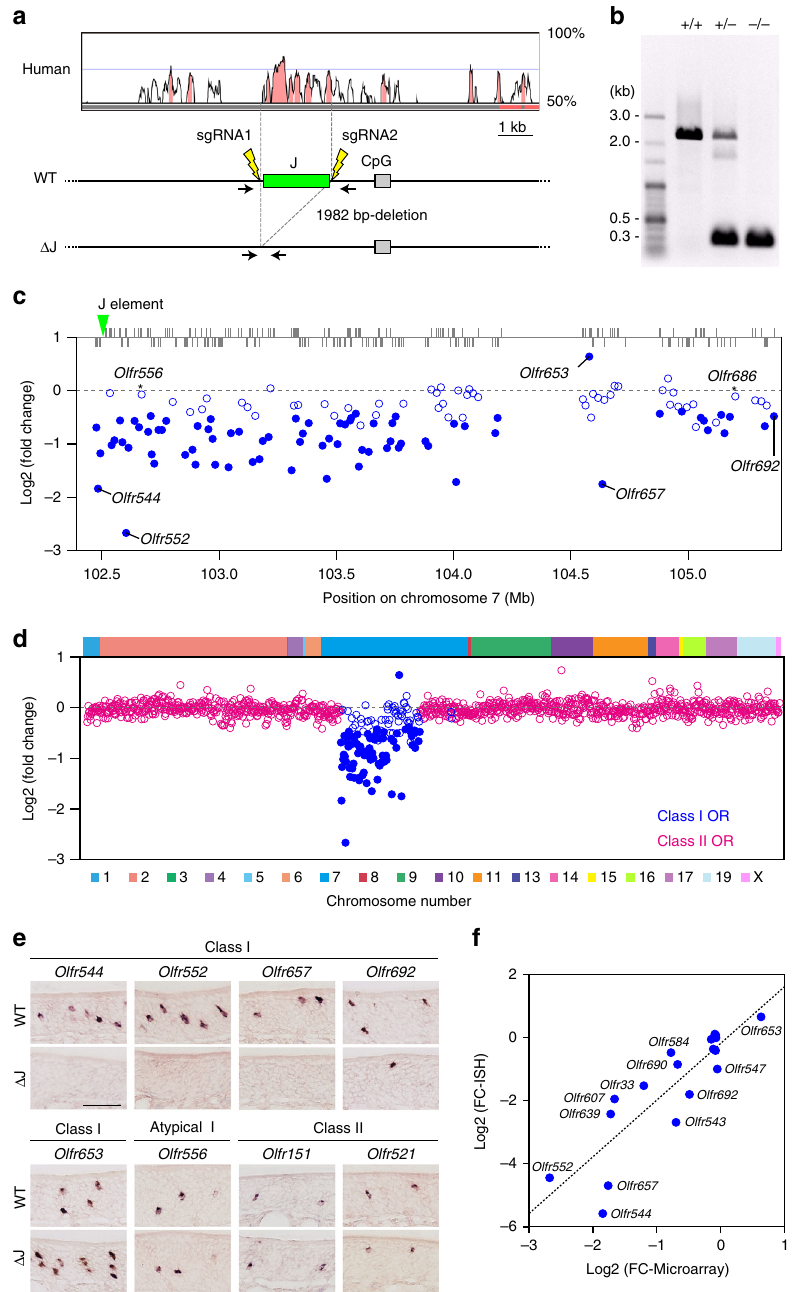
Fig. 4 Massive reduction in class I gene expression in Δ J. a A targeted deletion of the J element using the CRISPR-Cas9 system. b PCR genotyping of wild-type ( + / + ), heterozygous ( + / − ), and homozygous ( − / − ) mice using primers covering the J element. c , d Microarray analysis of OR gene expression in Δ J mice. c The log2-fold change (FC) values for class I OR genes are shown in the class I OR cluster position. A fold change criterion of 1.3 (decrease or increase) was used. Differentially expressed class I OR genes ( p < 0.05) are represented by fi lled circles ( n = 6). Among 129 tested intact class I OR genes within the class I cluster, the expression of 75 class I OR genes is decreased and that of one gene is increased. Pearson correlation coef fi cient r = 0.42, p = 9.7 × 10 − 7 . d The log2 FC values for all tested intact OR genes arranged according to their relative positions along the chromosome (class I, blue ; class II, magenta ; n = 6). e Single-color ISH analysis for fi ve class I OR genes, one atypical class I OR gene, and two dorsal class II OR genes in Δ J and wild-type mice. The scale bar is 50 μ m. f Correlation between log2 FC values detected by microarray ( horizontal axis ) and ISH ( vertical axis ) for twelve class I, two atypical class I, and four class II OR genes. n ≥ 3. Pearson correlation coef fi cient r = 0.87, p = 3.6 × 10 −